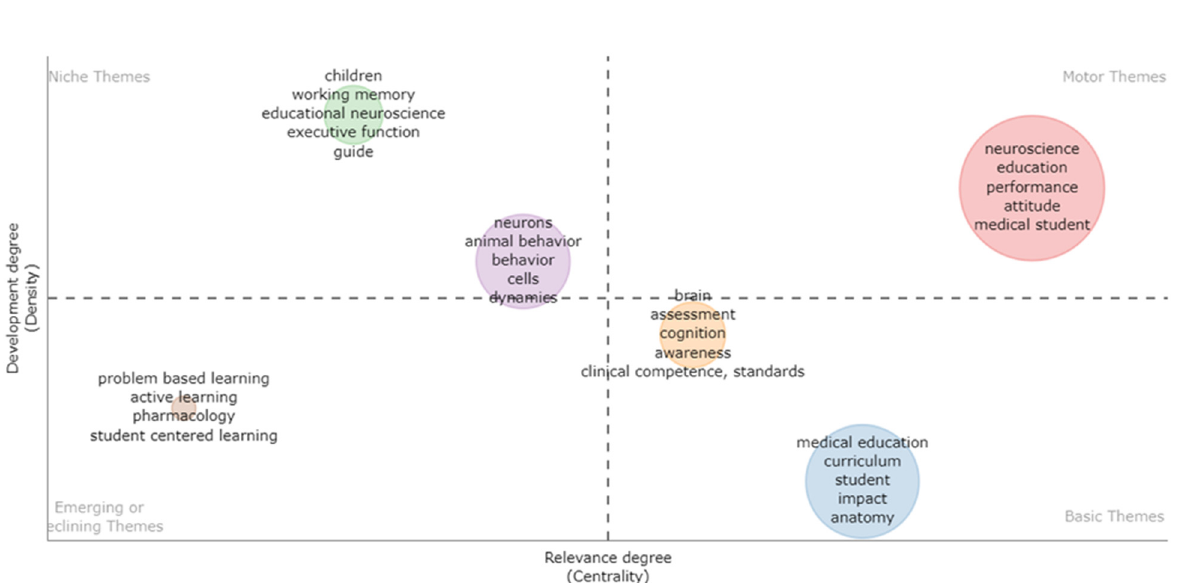
Figure 7. Strategic diagram for neuroscience in the field of education for 1995–2013.